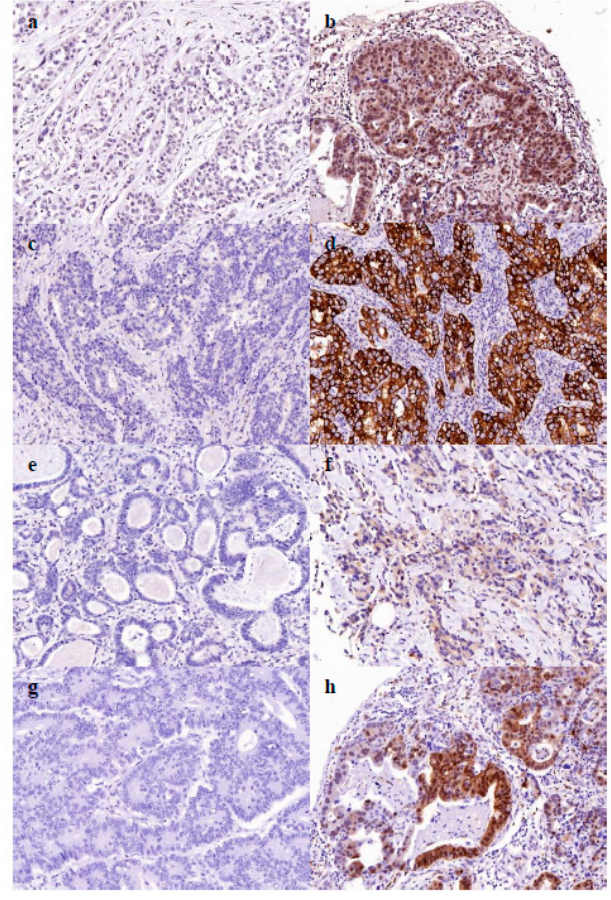
Figure 3. Tissue microarray (TMA) core of the cancer dormancy markers. ( a ) Negative expression of the NR2F1. ( b ) Positive expression of the NR2F1. ( c ) Negative expression of the NANOG. ( d ) Positive expression of the NANOG. ( e ) Negative expression of the MIG6. ( f ) Positive expression of the MIG6. ( g ) Negative expression of the PERK. ( h ) Positive expression of the PERK.